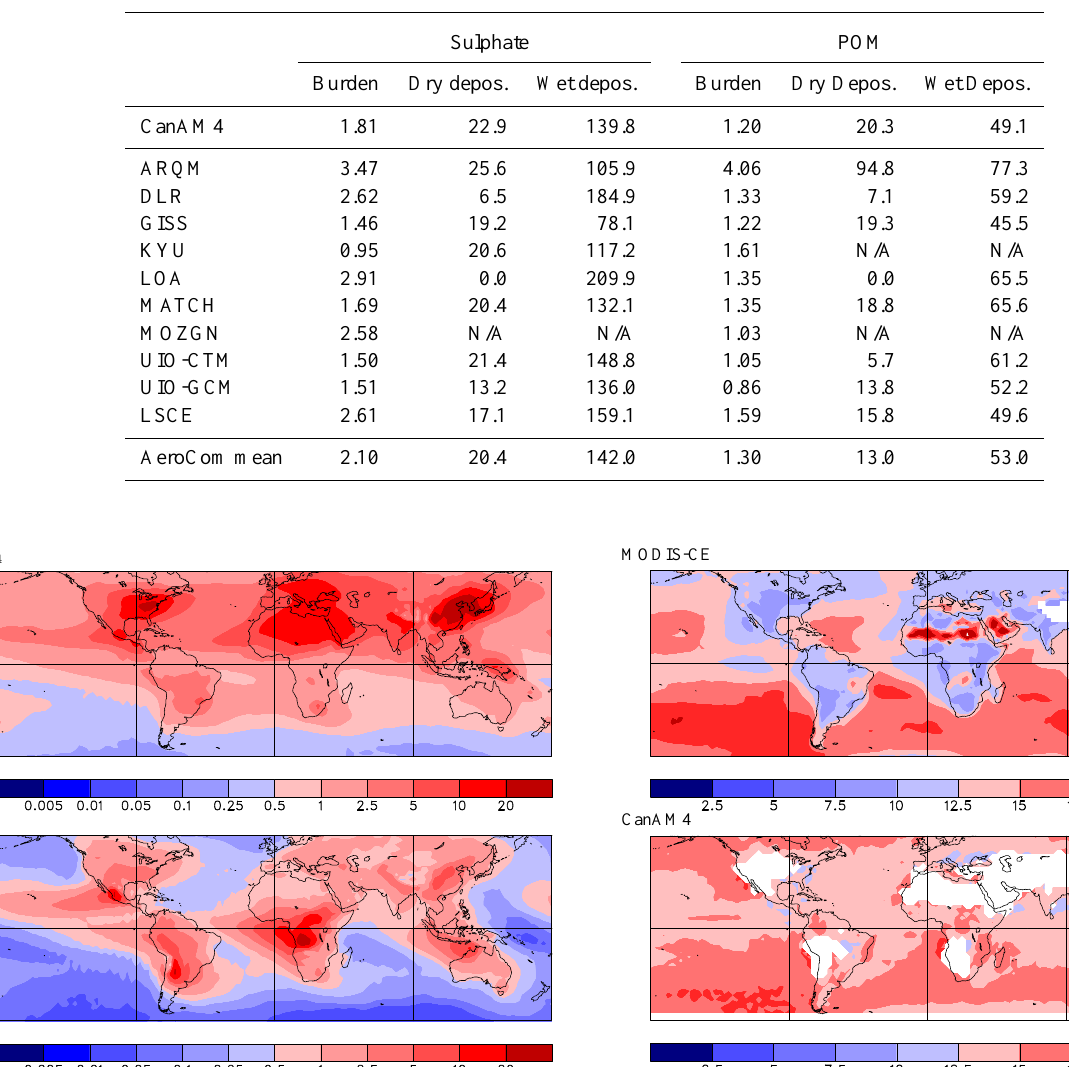
Table 1. Global annaul averaged aerosol burden (unit: Tg), dry and wet deposition fluxes (unit: Tg/yr) from CanAM4 and various global models from the AeroCom project. AeroCom mean model results are also listed.